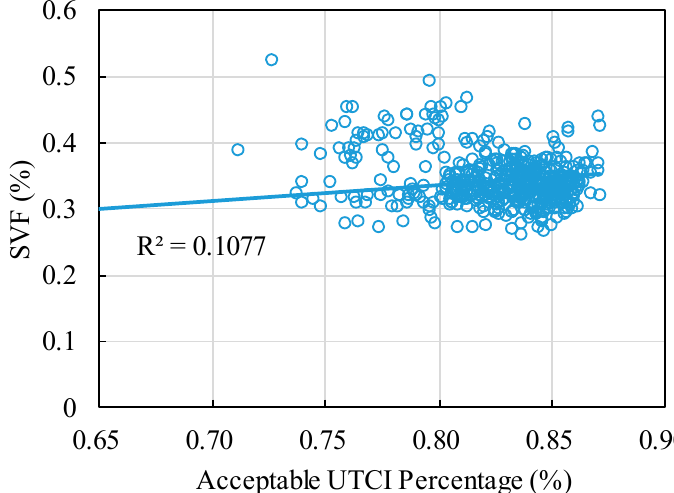
Figure 9. Correlation results of building enclosure, variation of building heights, and acceptable UTCI percentage at block level.